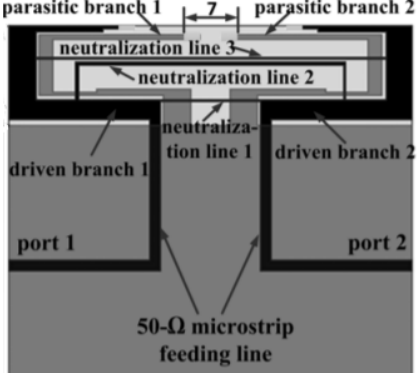
Figure 4. Neutralization line technique